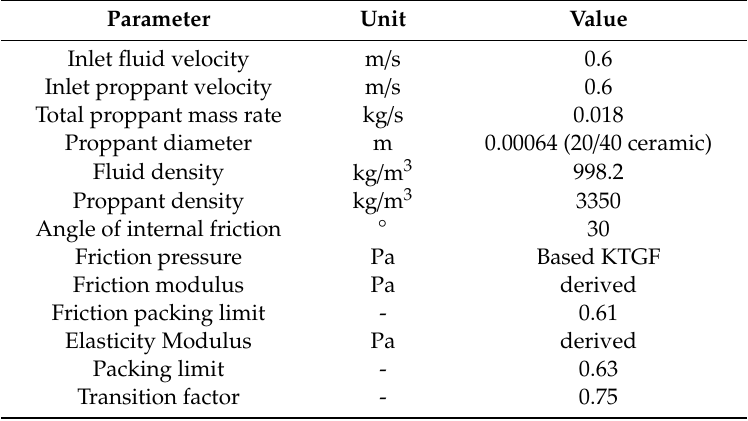
Table 4. Values of parameters in CFD